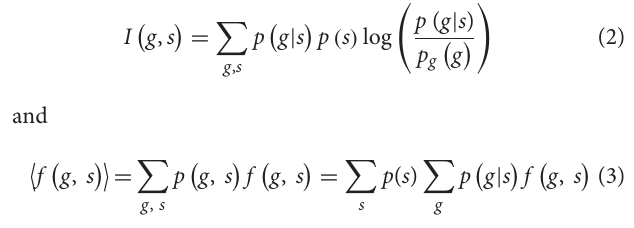
( Figure 3C , in gray), in principle centered on g ∗ ( s 1 ) .